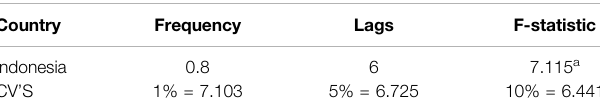
TABLE 3 | Results of